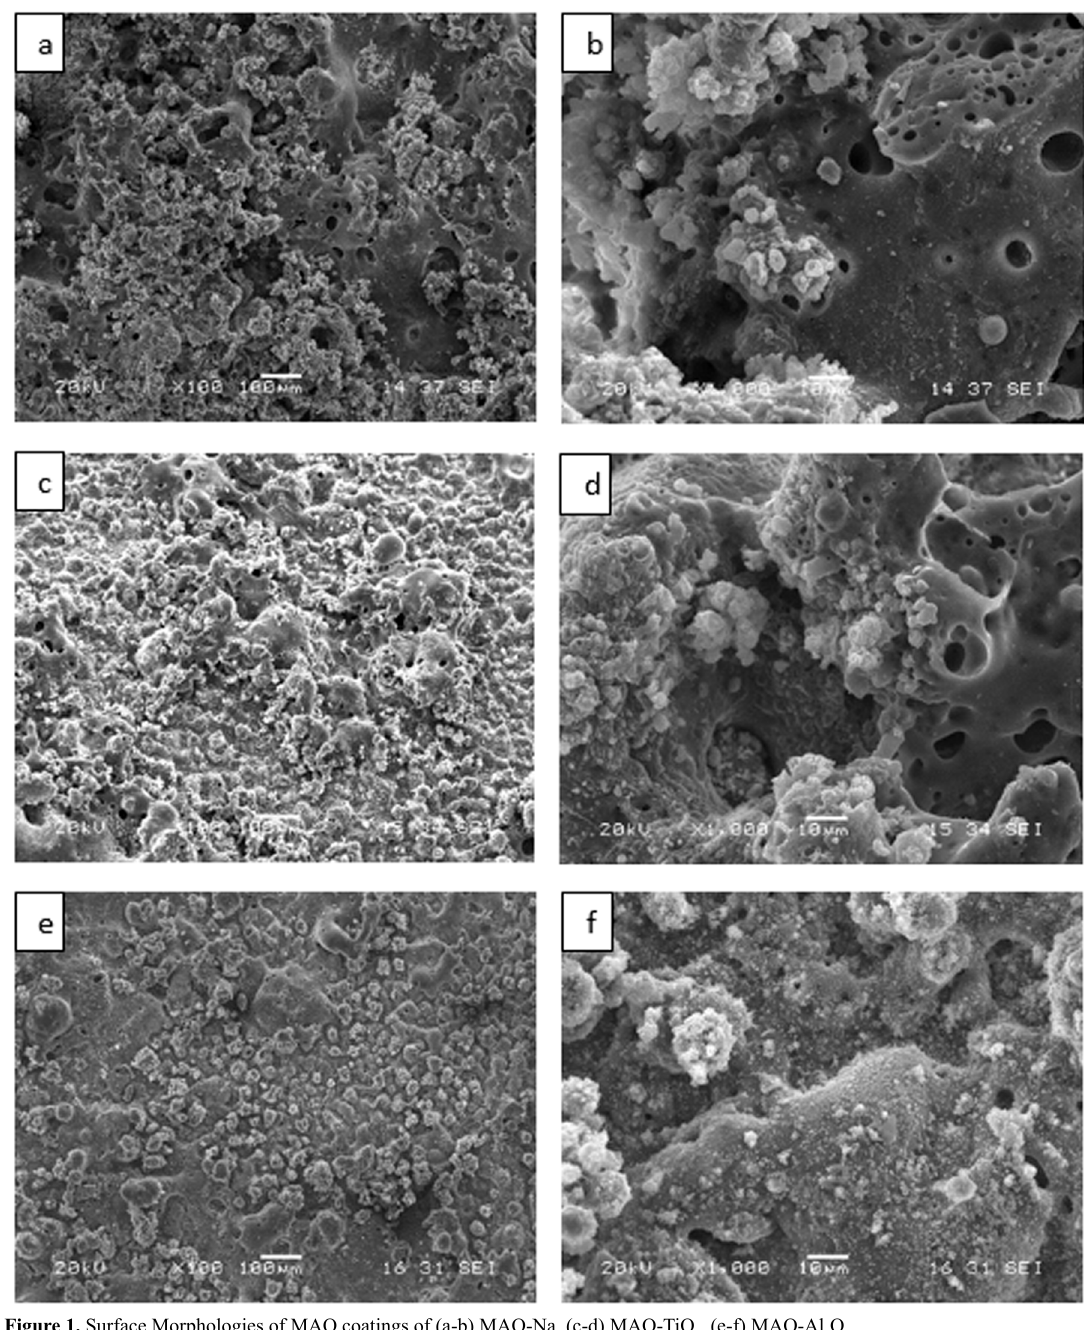
Figure 1. Surface Morphologies of MAO coatings of (a-b) MAO-Na, (c-d) MAO-TiO times (Fig.3b). The micro arc oxidization coating is structured with a porous layer and increasing the nano additive made the oxide layer denser. As is well